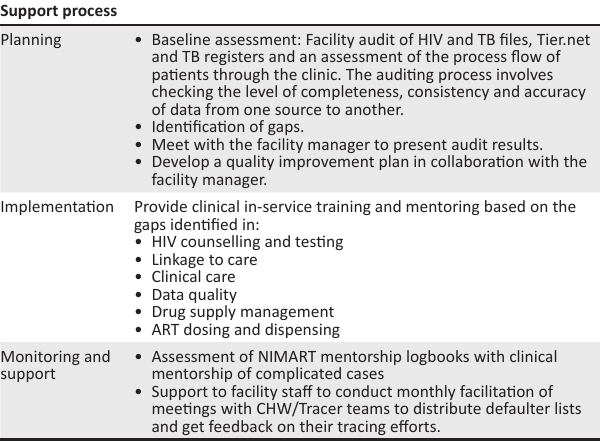
TABLE 2: Sequence of support